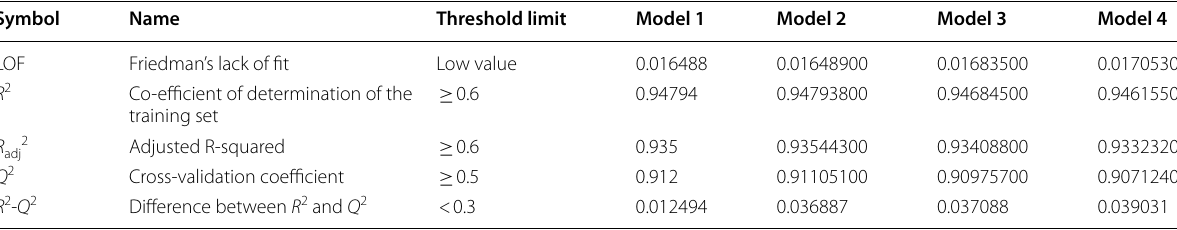
Table 2 Minimum recommended values for acceptable QSAR model Symbol